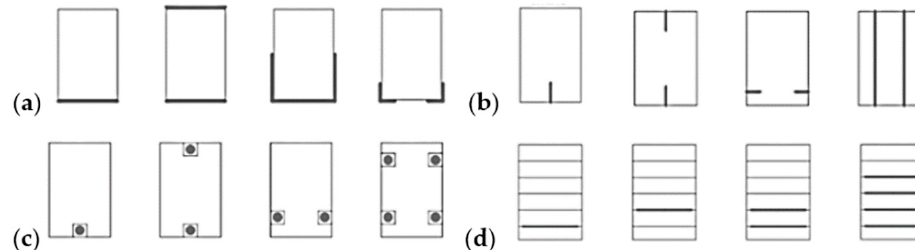
Figure 1. Methods of strengthening wooden beams with the use of CFRP strips according to [46]: ( a ) perimeter reinforcement, ( b ) internal reinforcement, ( c ) glued bars, ( d ) interlayer reinforcement for Glued Laminated Timber